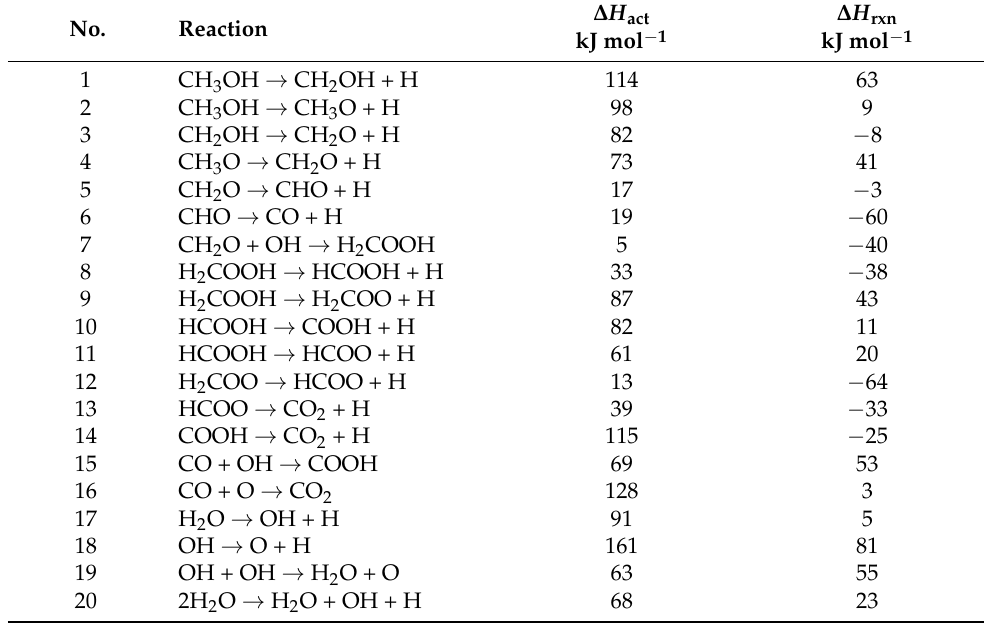
Table 2. Calculated forward activation enthalpy ( ∆ H act = H TS − H reactants ) and the reaction ( ∆ H rxn = H products − H reactants ) for the elementary reactions considered in this study on Ni 2 P(001) at 573